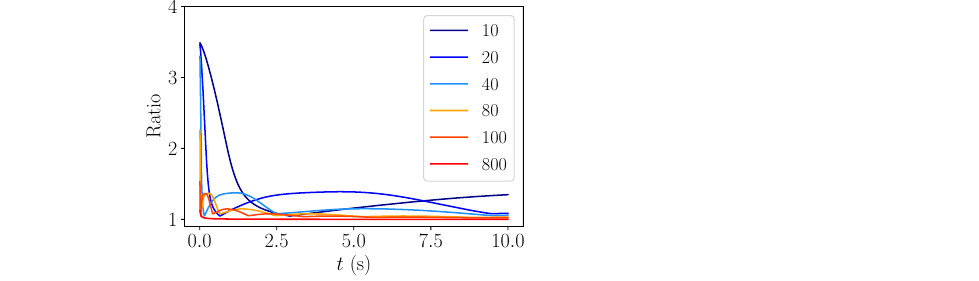
Figure 16. Plot of the maximum error ratio between simulation value and NIST value for thermal conductivity versus time for O 2 at 7.0 MPa